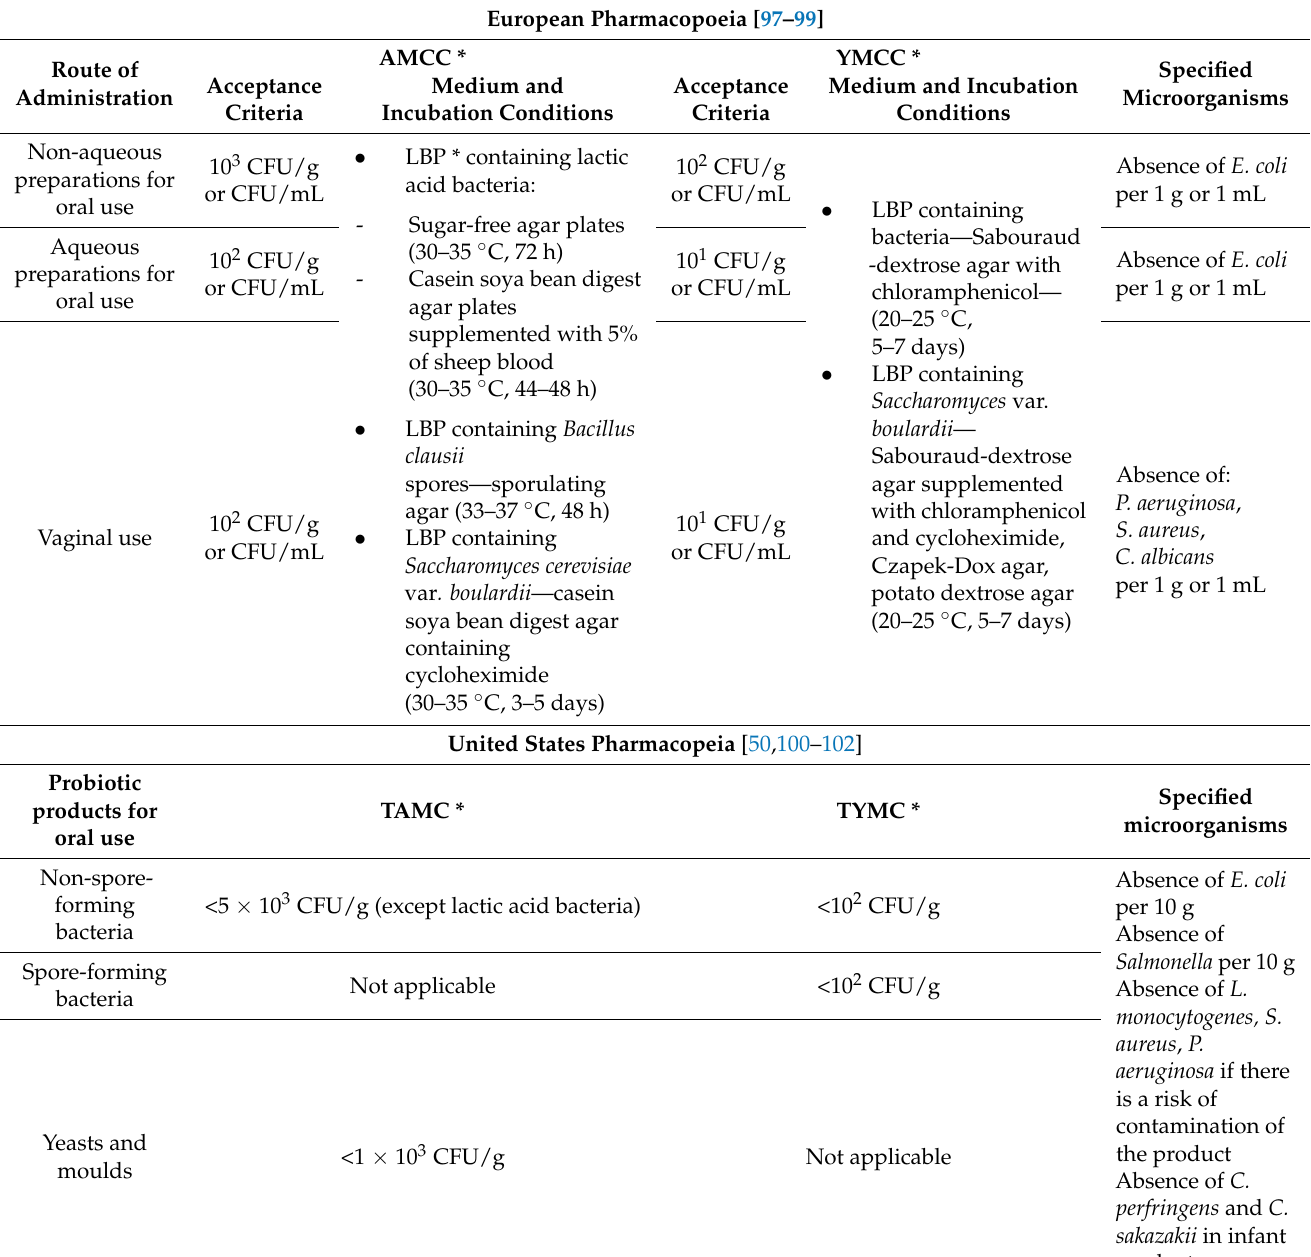
Table 4. Acceptance criteria for microbiological quality and cultivation conditions for medicinal products containing probiotic